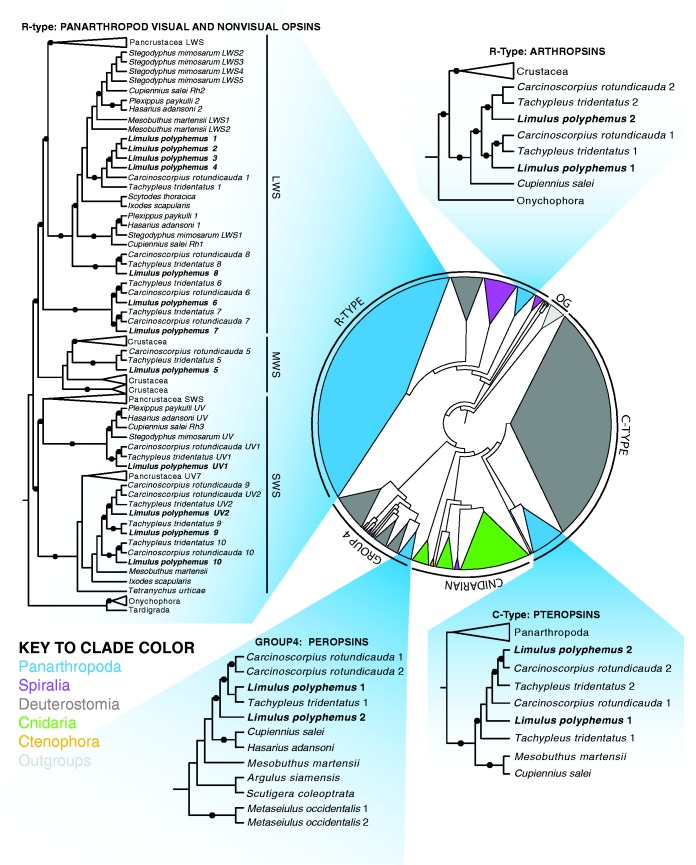
Opsin phylogeny. Maximum-likelihood tree of 743 genomic and expressed opsin sequences illustrating the four major evolutionary clades of opsins (C-type, R-type, Cnidarian, and Group 4), divided into subclades by major taxonomic groups (see key for color codes). Panarthropod groups are expanded to highlight the relationships among Limulus polyphemus (in bold) and arachnid and other xiphosuran opsin sequences. For the R-type clade containing the known panarthropod opsin genes, the spectral clades have been indicated as long wavelength sensitive (LWS), middle wavelength sensitive (MWS), and short wavelength sensitive (SWS). Black circles on branches indicate nodal support >80%.